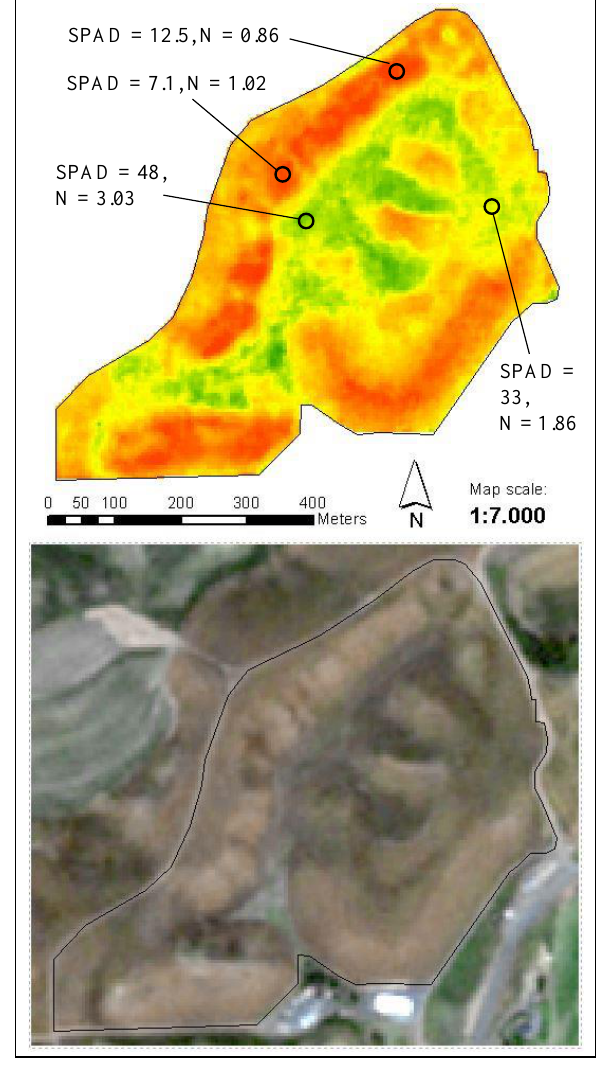
Figure 5. Map of potential within field senescence patterns (above) and corresponding RGB RapidEye image (below) at site U1.1. A selection of ground reference samples are denoted by black circles. Red and yellow colors indicate an advanced state of senescence (lower chlorophyll (SPAD) and nitrogen (N) concentration), while green colors indicate a less advanced senescence